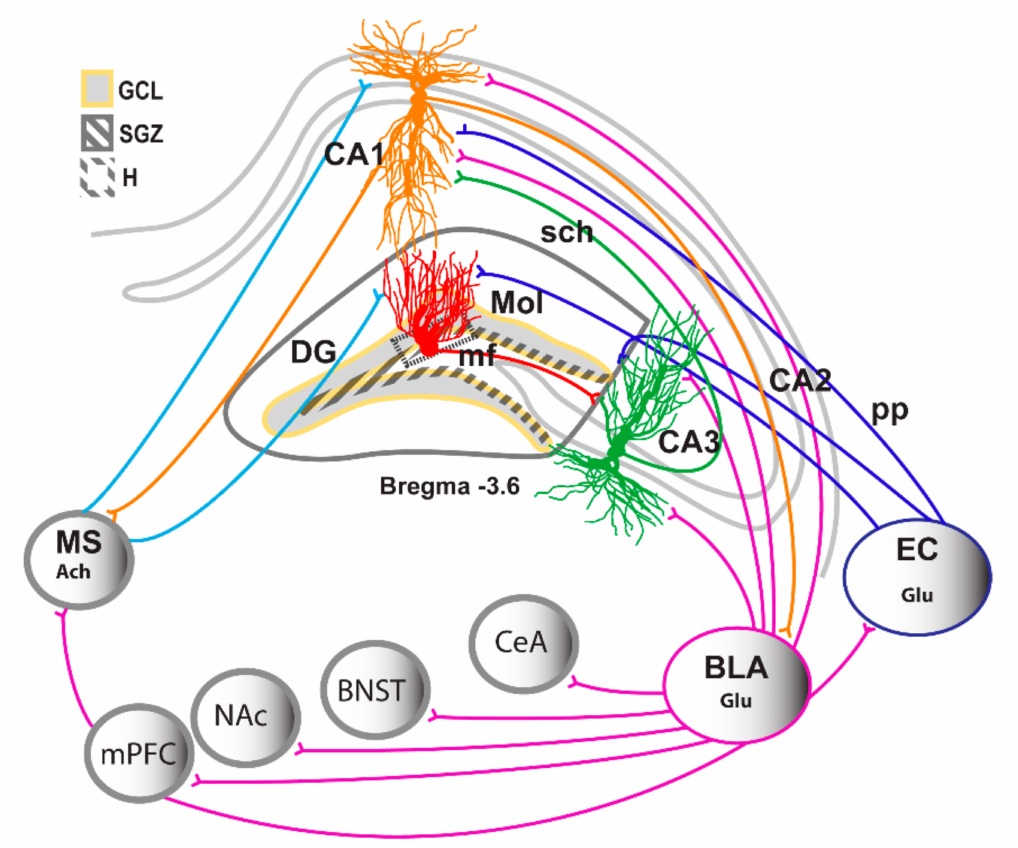
Figure 1. Modified from [13]. Simplified schematic representing projections in the hippocampus with emphasis on the inter- and intra- hippocampal circuits. Schematic representation of the coronal view of the hippocampus region indicating the subregions of the hippocampus and their location within the hippocampus; CA, Cornu Ammonis; CA1, CA2 and DG. Trisynaptic circuitry in the hippocampus is indicated with axons from the entorhinal cortex projecting unidirectionally to the apical dendrites of the hippocampal DG, CA1 and CA3 neurons (perforant path projection); DG neurons project to the apical dendrites of the CA3 pyramidal neurons (mossy fiber projection); CA3 neurons project to the apical dendrites of the CA1 neurons (schaffer collateral projection). The CA1 neurons have bidirectional projections to and from the BLA. The BLA also sends projections to the medial prefrontal cortex (mPFC), nucleus accumbens (NAc), bed nucleus of the stria terminalis (BNST) and central nucleus of the amygdala. The DG and CA1 also receive direct inputs from the medial septum